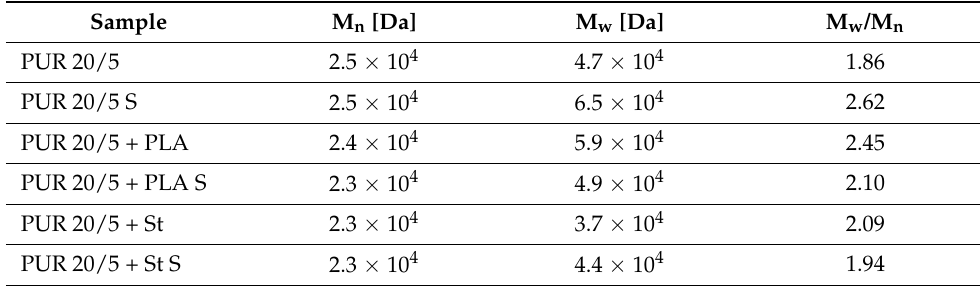
Table 3. Changes in the molecular weight of PUR20/5 and its blend with PLA and St after 36 weeks of exposure to